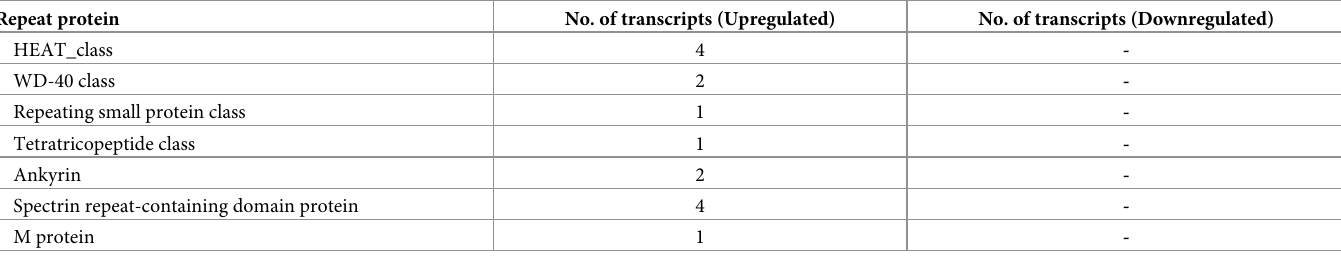
Table 2. Differentially expressed repeat protein class transcripts identified in anhydrobiotic H . indica . Repeat protein No. of transcripts (Upregulated) No. of transcripts